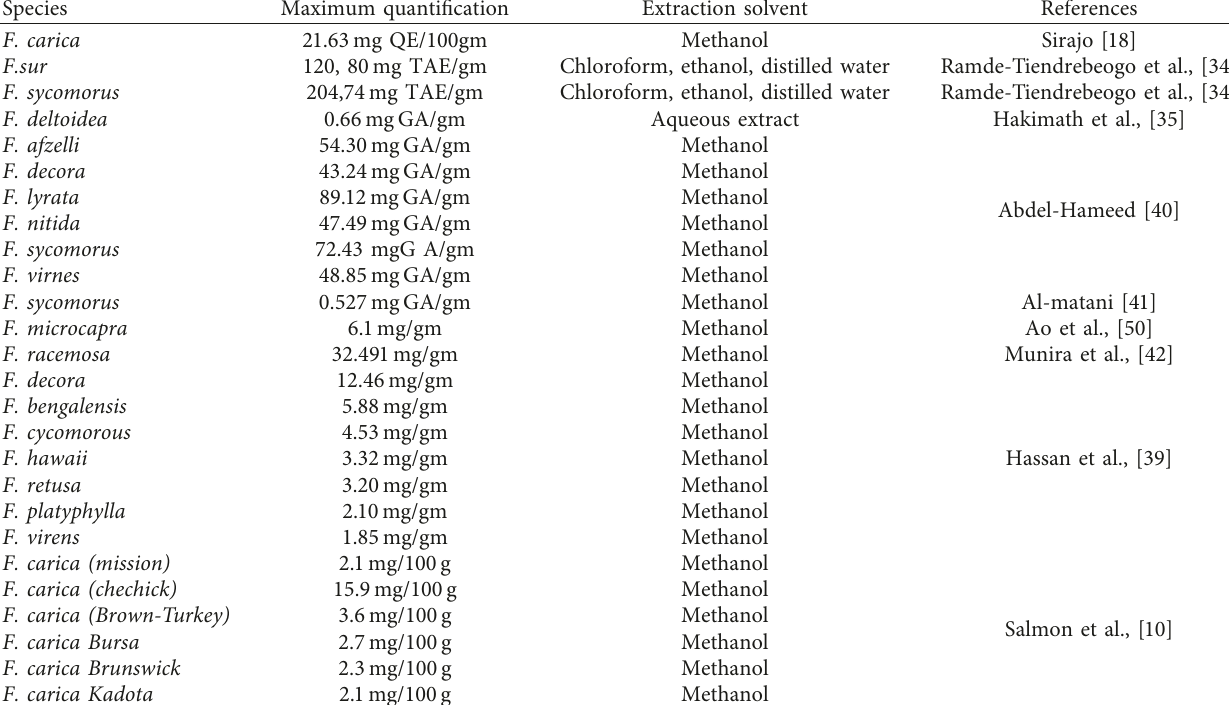
Table 6: Flavonoids present in the species used as both fresh fruit and species belonging to genus Ficus . Species Maximum